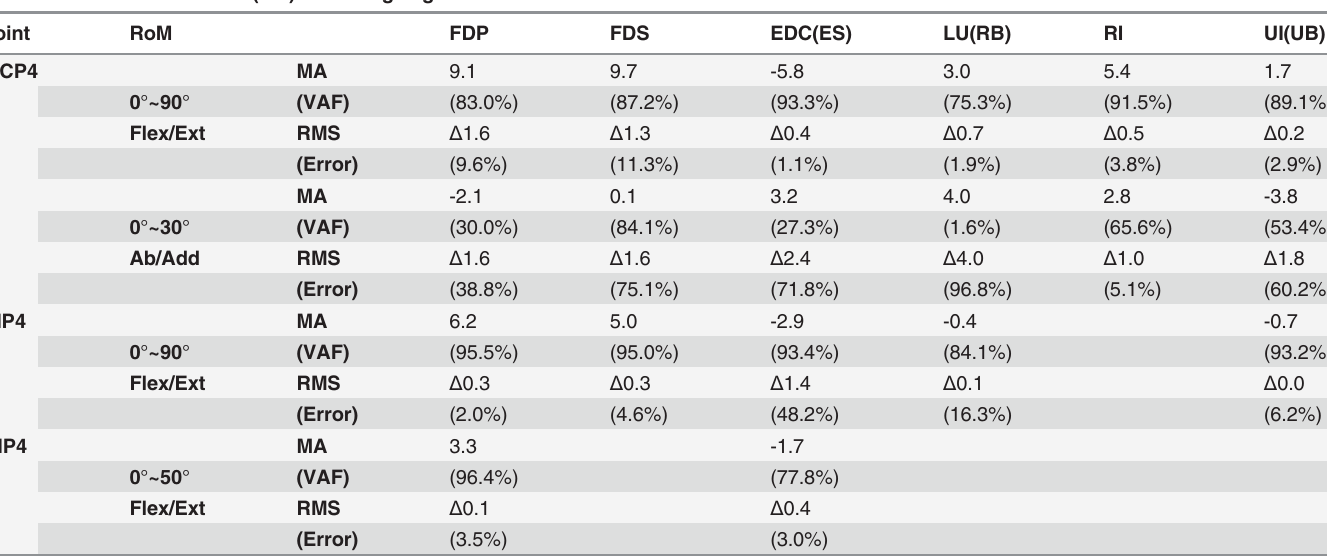
Table 5. Mean moment arms (MA) of the ring finger.